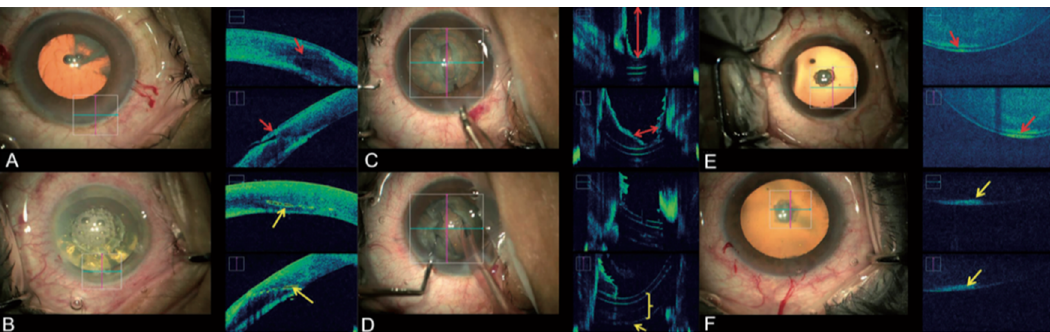
Figure 4. MI-OCT assisted Cataract surgery: The left column shows en-face view. The right column shows the accompanying MI-OCT image. ( A ) Manual keratome corneal incision (red arrows). ( B ) femtosecond laser-assisted corneal incision (yellow arrows). ( C ) Depth and width of trench before dividing the nucleus (red arrows). ( D ) Image after nucleus division (posterior capsule, yellow arrow), epinuclear plate (yellow bracket). ( E ) Pseudo-posterior polar cataract: a gap between lens and posterior capsule (red arrows). ( F ) True posterior polar cataract: no gap between lens and posterior capsule (yellow arrows). Reproduced with the permission from reference [58].